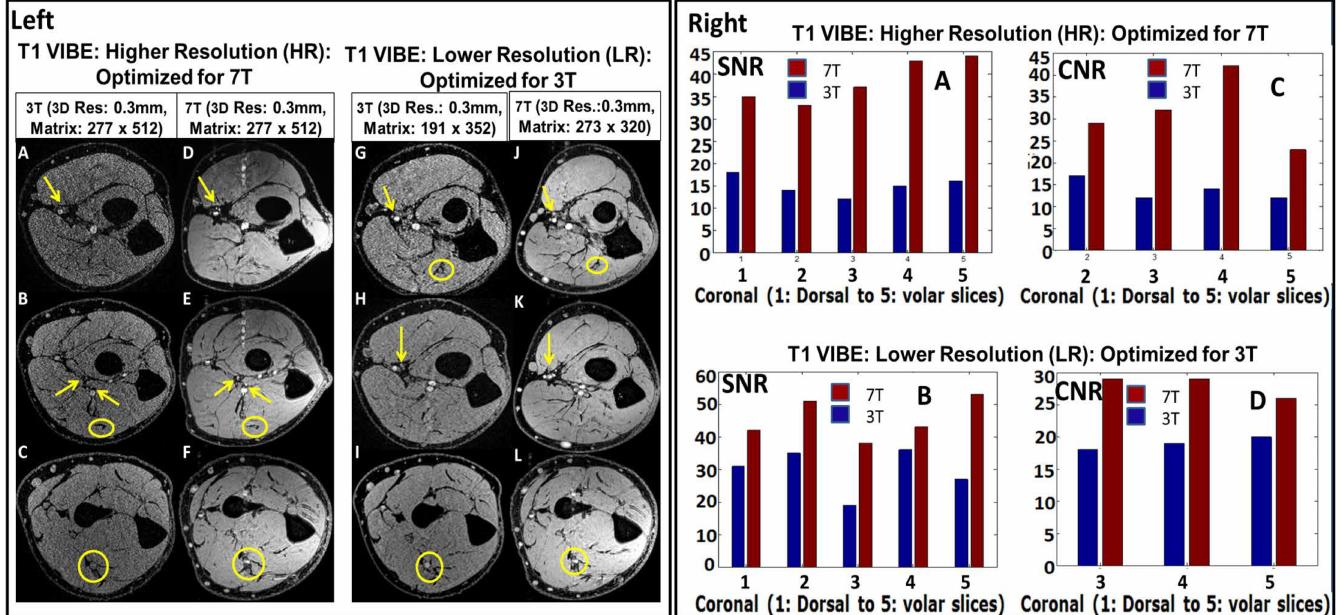
Fig 1. Left: 3T vs. 7T T1 VIBE images on both higher[HR which is optimizedfor 7T] and lower [LR which is optimizedfor 3T] resolutions[as described Table 1]. In the 3T images [A, B, C, G, H and I], smaller order vessels as indicatedby arrows are barely visible; while they are well detected on the 7T images [D, E, F, J, K and L]. Yellow arrows indicatemicro-vesselbranchesand yellow ellipses delineate nerves from surroundingmuscle plane. Note motion and pulsatileflow artifacts [band of bright points] originatingfrom the median artery in the anterior to posterior phase encoding direction. Right: SNR and CNR charts for T1 VIBE images. [A and B] and [C and D] represent SNR and CNR; respectively.The 7T SNR and CNR were ~ 2/1.5 times that of 3T for the HR/LR scans, respectively. Out of all three volunteer, the above data is from singlevolunteeronly.